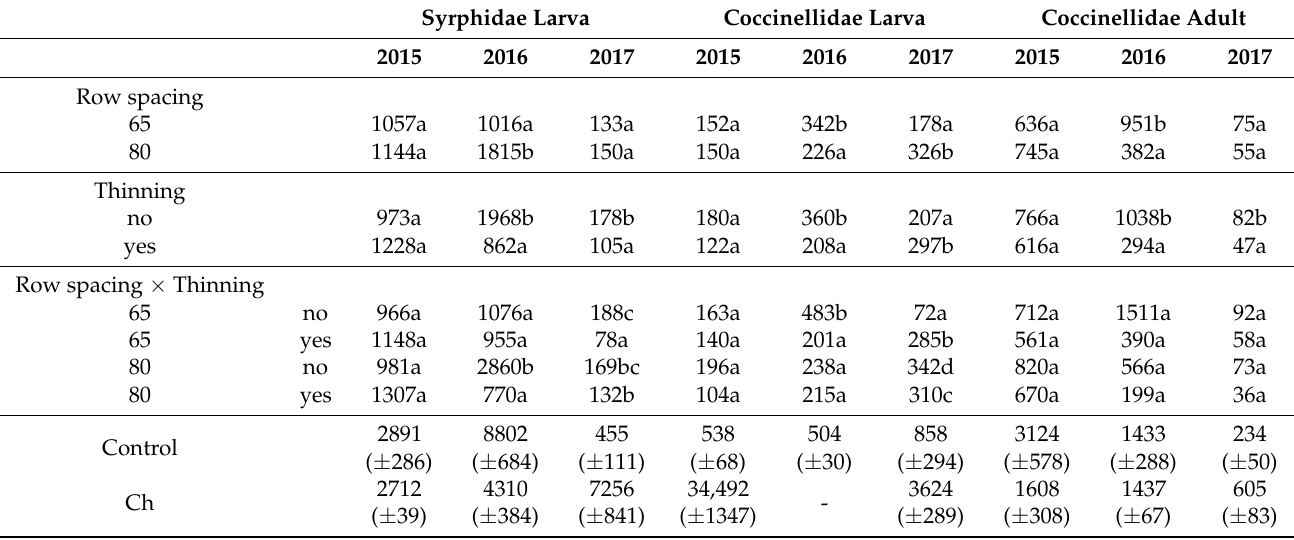
Table 4. The number of aphids per predator (larva of Syrphidae or Coccinellidae, adult of Coccinellidae) in the 2015–2017 seasons.